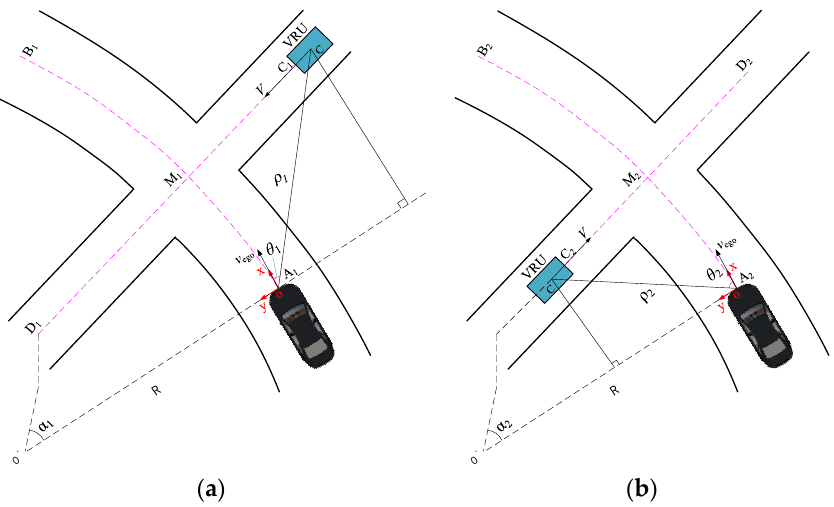
Figure 1. Schematic diagram of the movement of the vehicle and VRU: ( a ) a VRU crosses the road from the outside to the inside of the curve; ( b ) a VRU crosses the road from the inside to the outside of the curve.